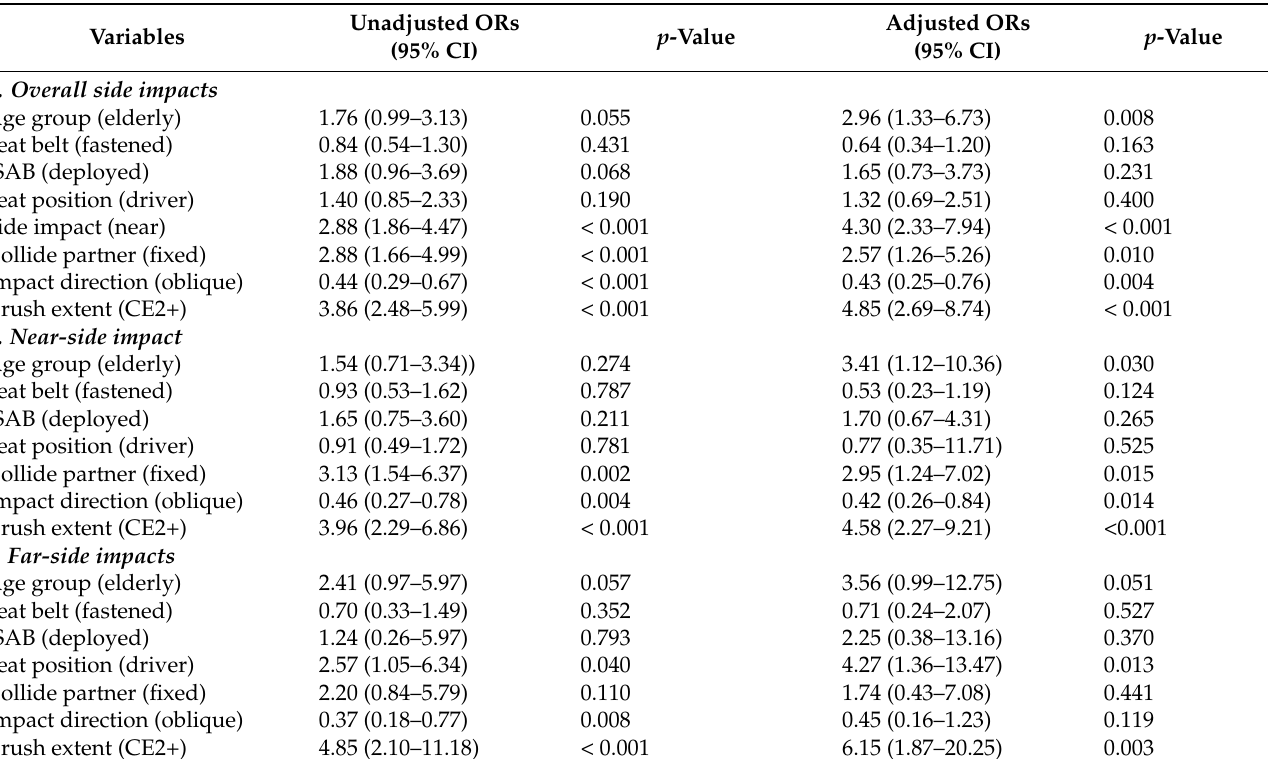
Table 2. Multiple logistic regression analysis on thoracic AIS2+